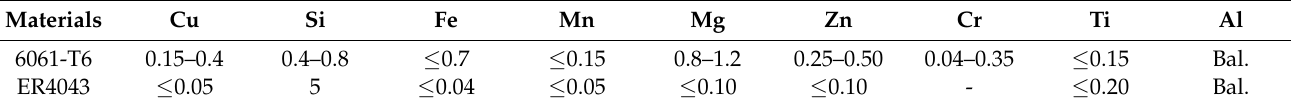
Table 1. Chemical composition of 6061-T6 and ER4043 (wt.%).